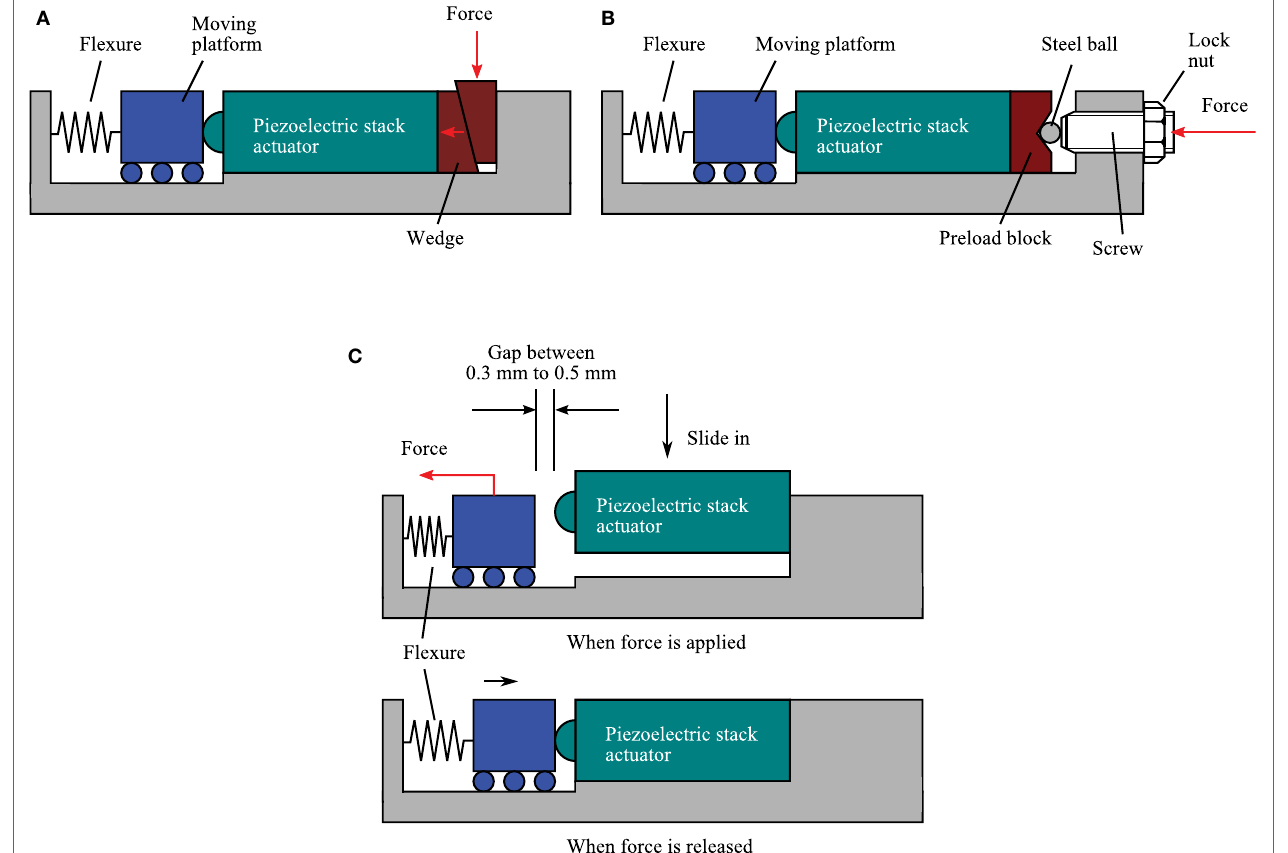
FIGURE 4 | Common preload techniques used in piezoelectric stack actuated nanopositioning systems . (A) Using a pair of wedges. (B) Using precision screw and lock nut. (C) Using only flexures.